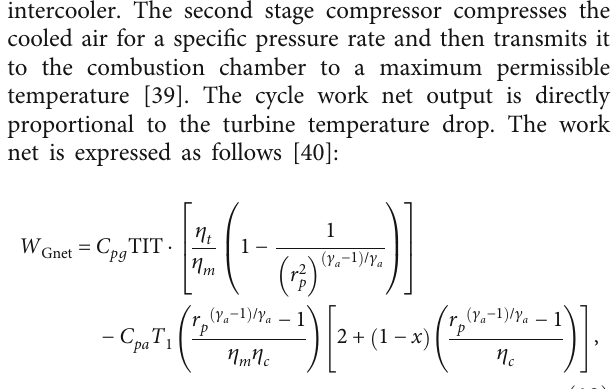
TurbineC.C.H.E. W shaft Figure 1: Schematic diagram of di ff erent gas-turbine